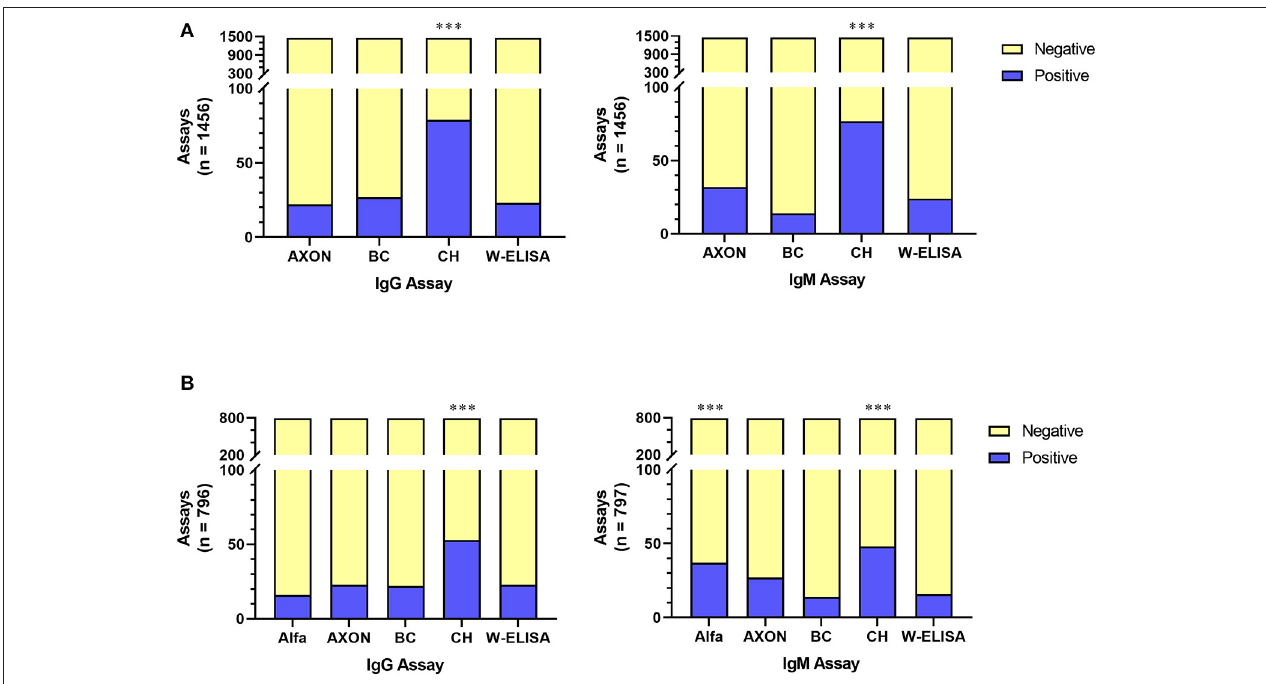
FIGURE 3 | Comparison of serological tests for both IgG and IgM antibodies across either 4 assays (A) or 5 assays (B) . In all comparisons, 20 assays were conducted on control samples and the remainder was on participant samples. Test performance was compared to the W-ELISA data; p < 0.001 (***). Alfa, Alfa LFA; AXON, AXON LFA; BC, Beckman Coulter immunoassay; CH, CareHealth LFA; W-ELISA, Weighted ELISA.